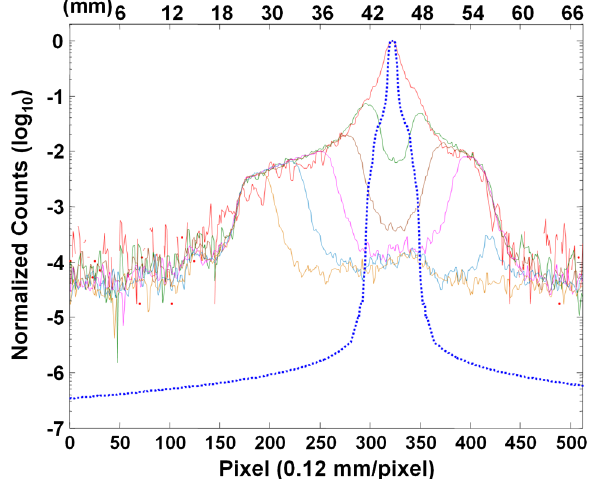
FIG. 15. Normalized horizontal scans of selected beam images presented in Fig. 14; with the measured PSF shown in Fig. 9 (blue dotted line); upper axis: scale at the source plane; lower axis: scale at intensifier plane.